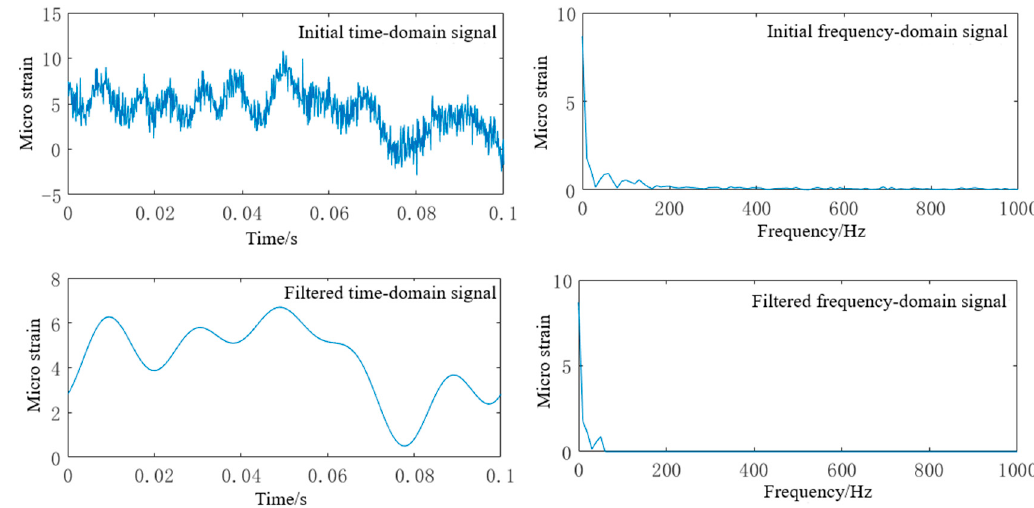
Figure 6. Filter processing of the rock dynamic strain data.